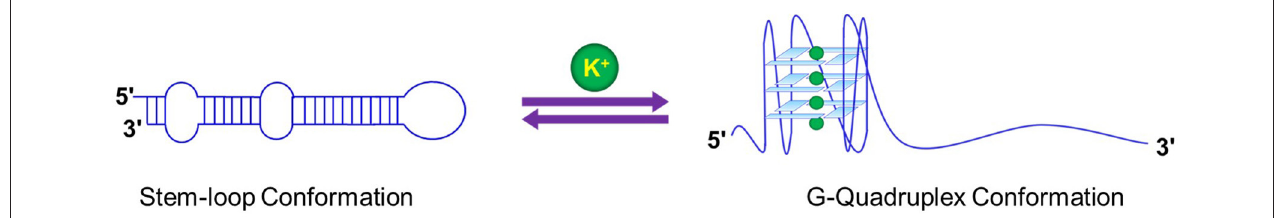
FIGURE 6 | Structural switch in response to ionic environment in miRNA 92b may influence the processing and the biogenesis of the G-quadruplex harboring miRNAs.